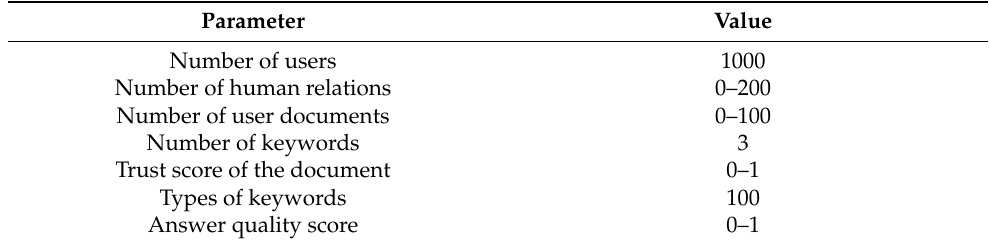
Table 1. Experimental data of performance evaluation.